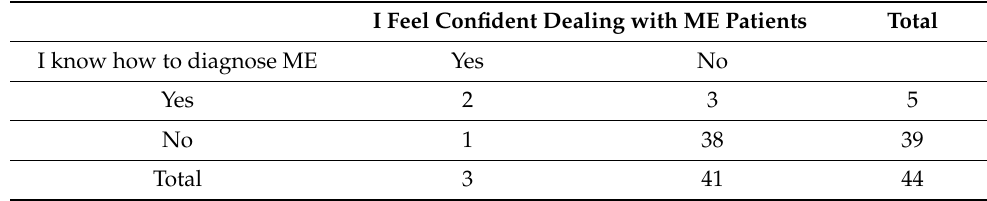
Table 2. Relationship between confidence in diagnosing ME and confidence in managing it. I Feel Confident Dealing with ME Patients